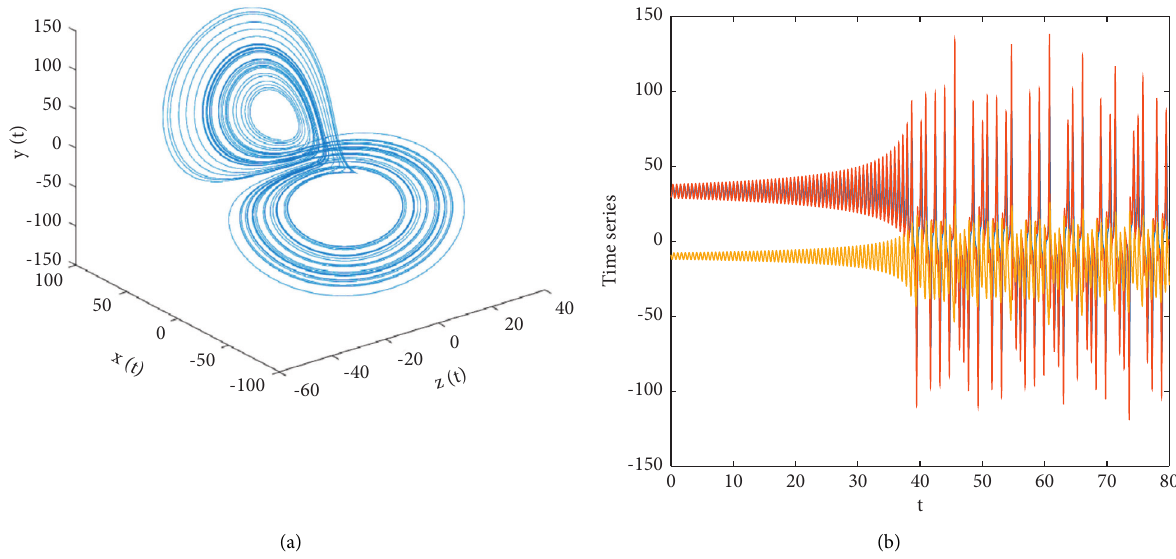
, τ � 0 . 23 > τ 0 is taken and system (1) is chaotic at the initial values ( 30 , 30 , − 9 ) : (a) the chaotic attractor of 2 2